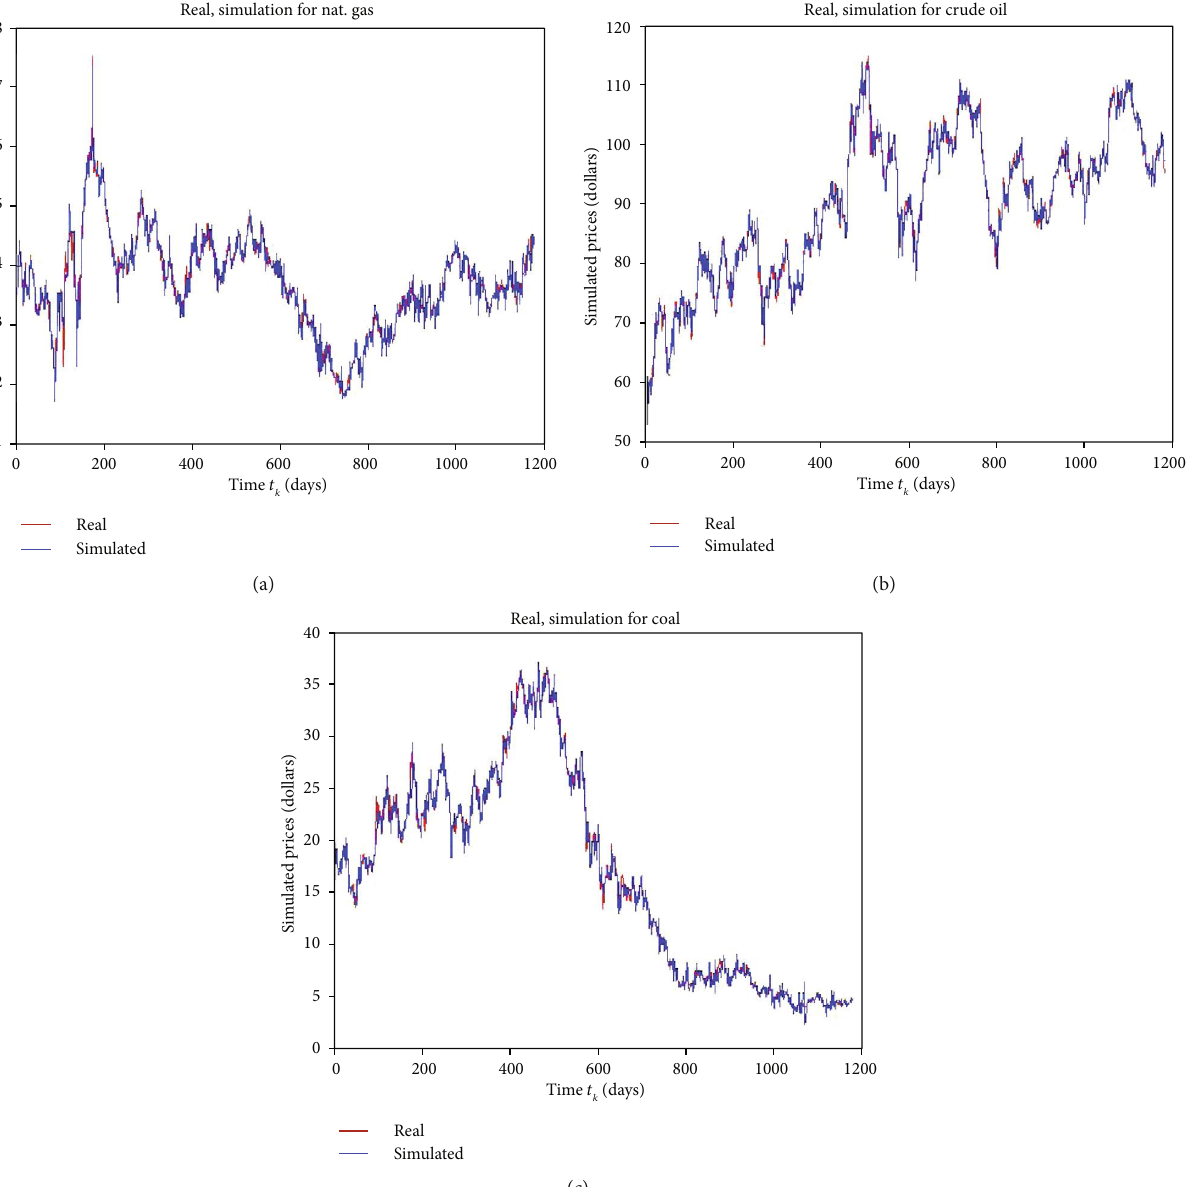
Figure 14: Real and simulated prices (with jump) for natural gas, crude oil, and